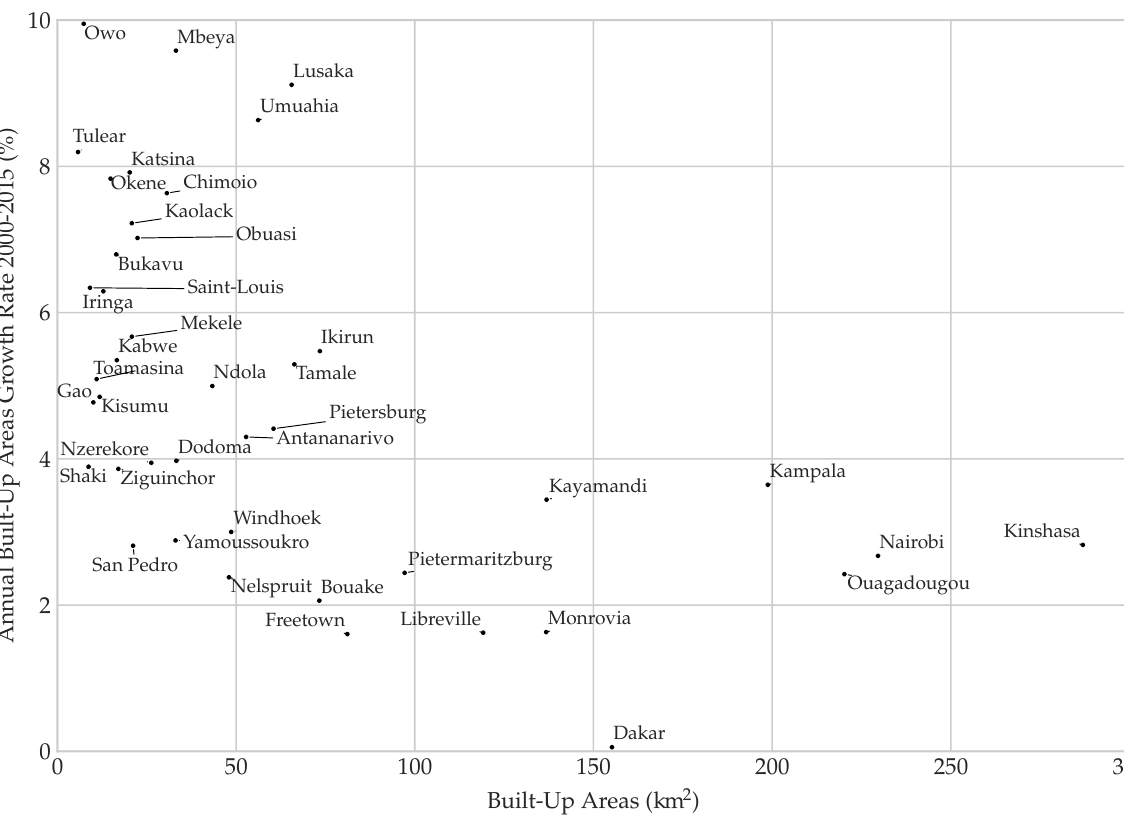
Figure 8. Total surface of built-up areas in 2000 and annual built-up areas growth rates between 2000 and 2015 for each case study. Johannesburg (725 km 2 of built-up areas, annual growth rate of 1.1%) and Onitsha (missing data) are excluded from the graph.